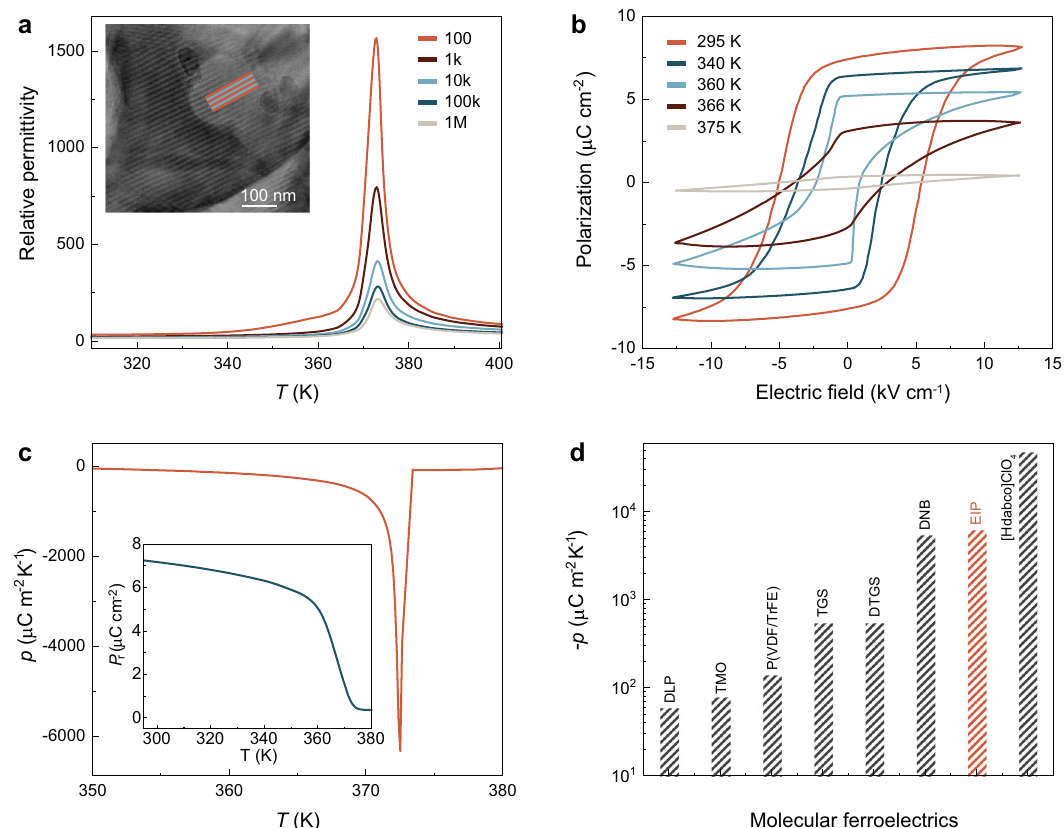
Fig. 2 Ferroelectric and pyroelectric properties of EIP. a Temperature dependence of relative permittivity for EIP at different frequencies. Inset shows a HRTEM for unpoled EIP. b P – E loops of EIP measured at 200 Hz and different temperatures. c Temperature-dependent pyroelectric coef fi cient ( p ) for EIP. Inset shows remnant polarization as a function of temperature. d Pyroelectric coef fi cients for representative molecular ferroelectrics with EIP highlighted in